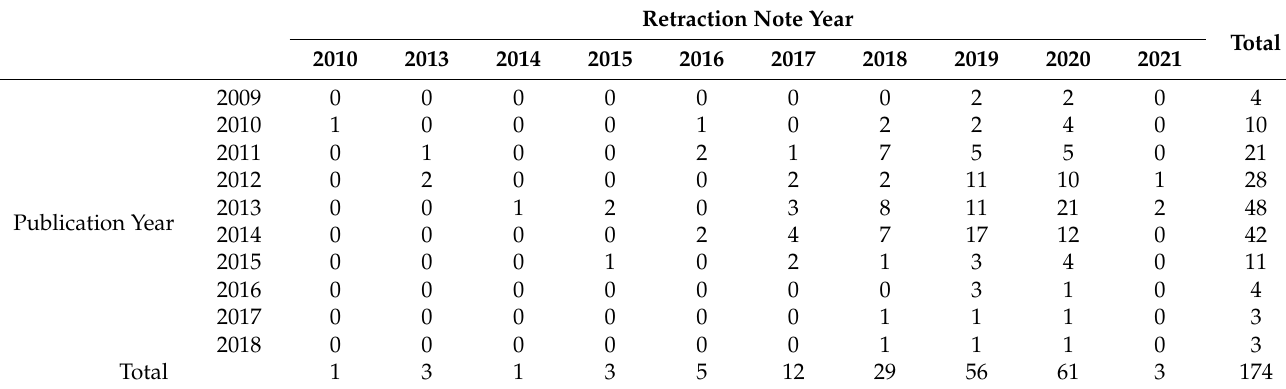
Table 6. Evolution of the PLOS image retractions.